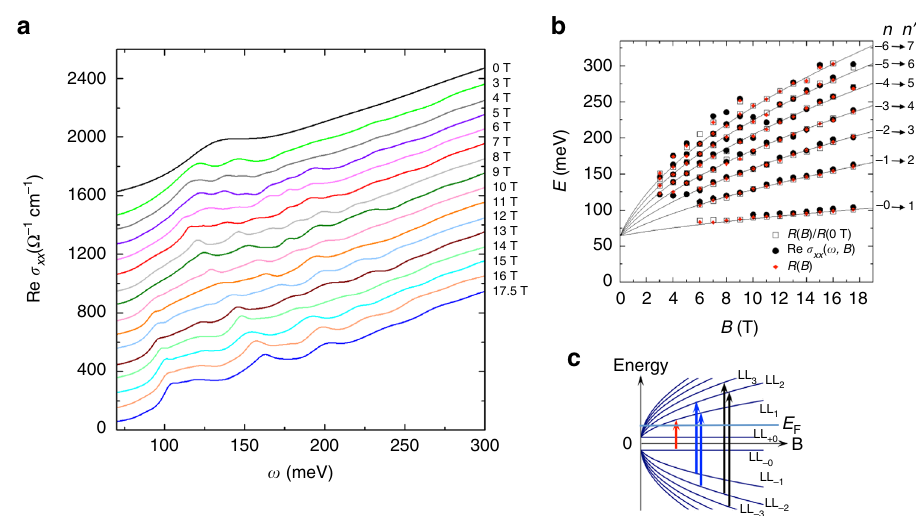
Fig. 3 LL transitions of bulk states. a The real part of the optical conductivity Re σ xx ( ω ) in several magnetic fi elds. For clarity the spectra are displaced from one another by 100 with the spectrum at B = 17.5 T shown at its actual value. b The energies of the observed transitions as a function of magnetic fi eld. Symbols : data. Solid lines : fi ts to the data using Eq. (1) discussed in the text with Δ = 64.5 meV and v F = 0.4 × 10 6 m s − 1 . The observed resonances can be assigned to LL transitions T n , which is due to transitions LL -( n − 1) → LL n and LL - n → LL n − 1 for n > 1 and LL − 0 → LL 1 for n = 1. c Schematic of LLs of the bulk states. The arrows illustrate T 1 – T 3 shown in Ω − 1 cm − 1 , and all frequencies are in cm − 1 . From n bulk , m bulk , and Eq. (2), we estimate that SW bulk (cid:2) 1 : 6 ± 0 : 5 ð Þ ´ 10 4 Ω (cid:3) 1 cm (cid:3) 2 for